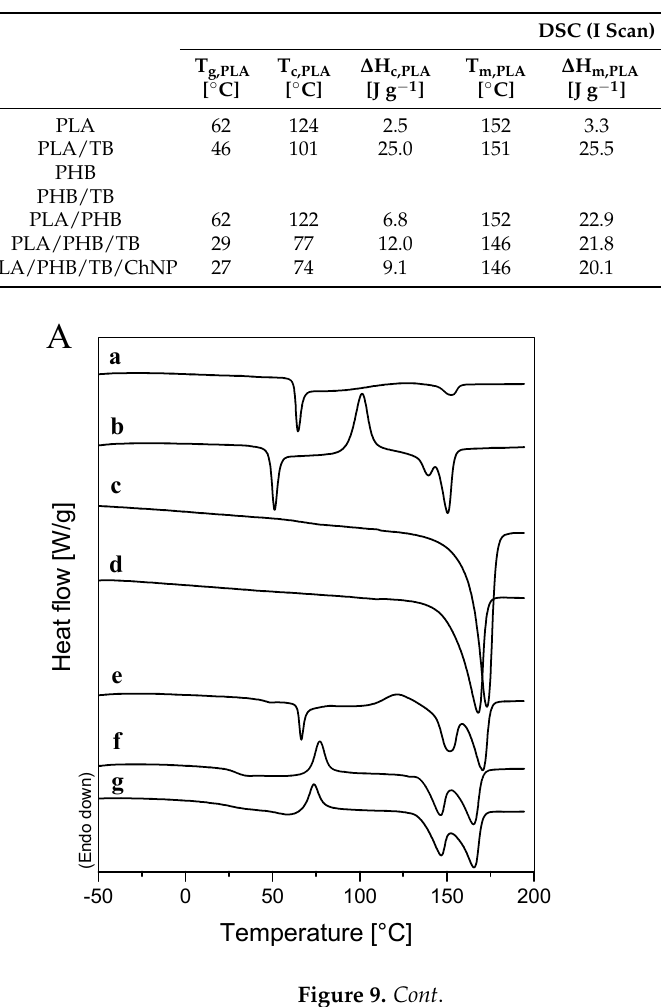
Table 4. Thermal characterization data by DSC (first heating scan) and TGA analysis of PLA- and PHB-based materials.